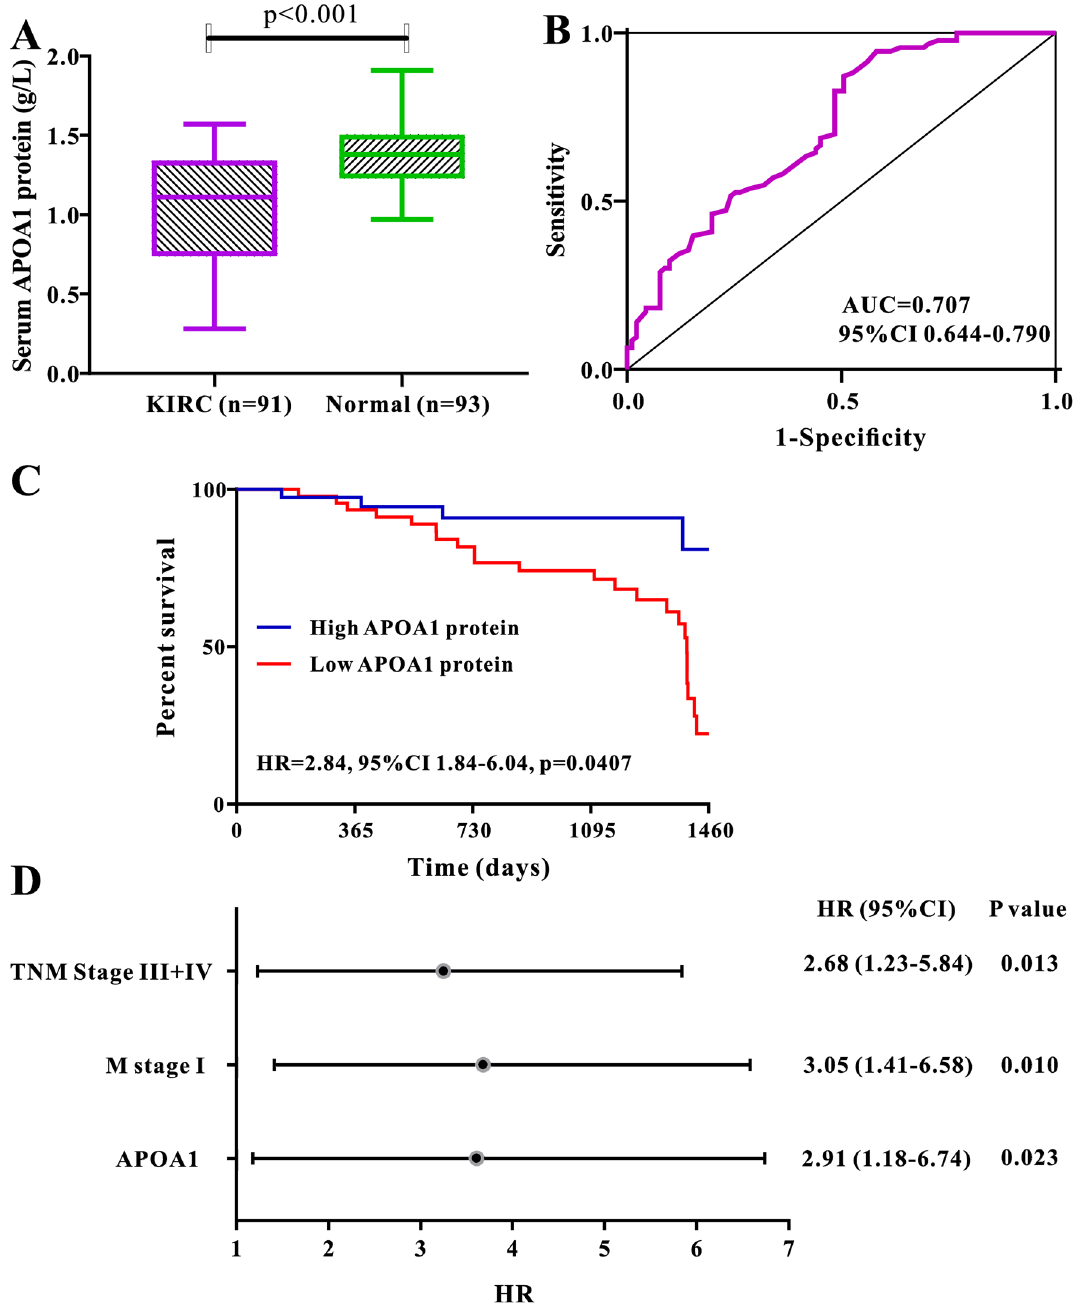
Figure 4. Diagnostic and prognostic significance of serum APOA1 protein in KIRC patients by Grahpad Prism version 9.0 (https:// www. graph pad. com/ scien tific- softw are/ prism/). ( A ) Levels of serum APOA1 protein in healthy individuals are much higher than that in KIRC patients ( p < 0.001). ( B ) ROC curve of serum APOA1 protein for the identification of KIRC patients from normal controls. ( C ) Kaplan–Meier plot of serum APOA1 protein among 91 cases of KIRC patients. ( D ) Forest plot of the multivariable analysis of overall survival in KIRC